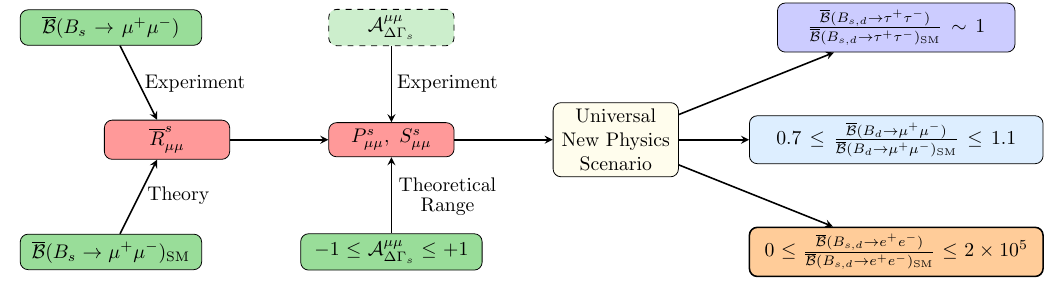
Figure 2 . Flowchart illustrating the analysis and interplay of the various B 0 within the considered (cid:13)avour universal NP scenario, as discussed in the